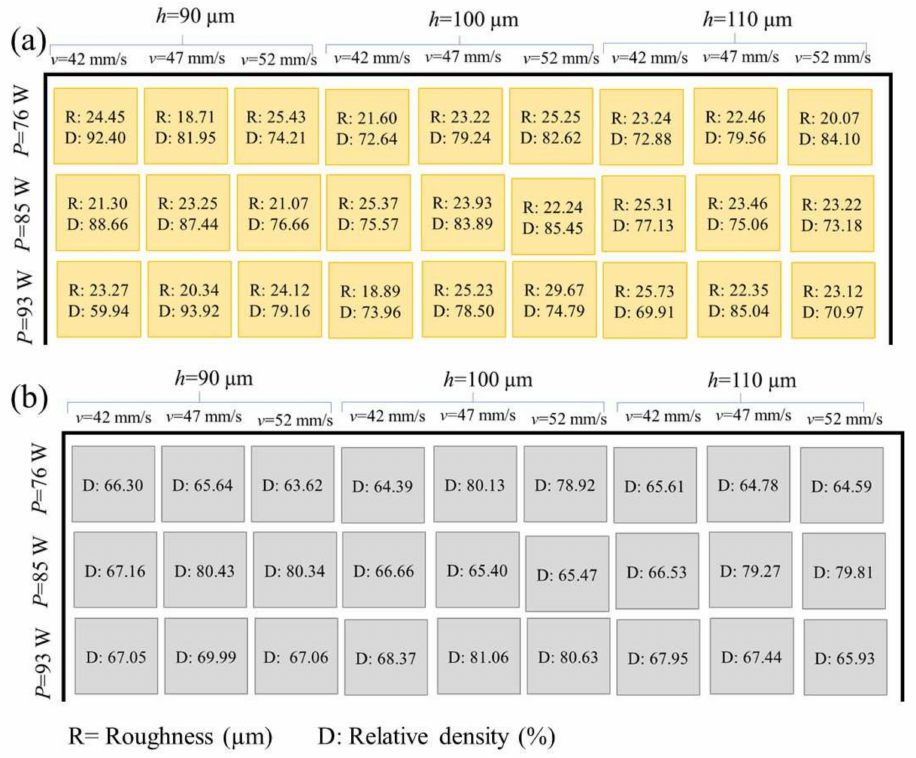
Figure 3. Photos of laser powder bed fusion additively manufactured ( a ) Cu and ( b ) Cu-CNT samples at different manufacturing parameters; process parameters can be found from the number on top of each sample and Figure 1. Insets show close-up view of one of the samples for better comparison.